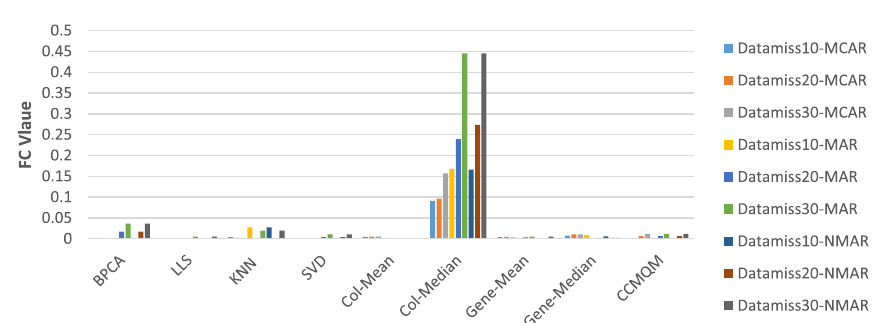
Fig. 6 Fisher discriminant test values